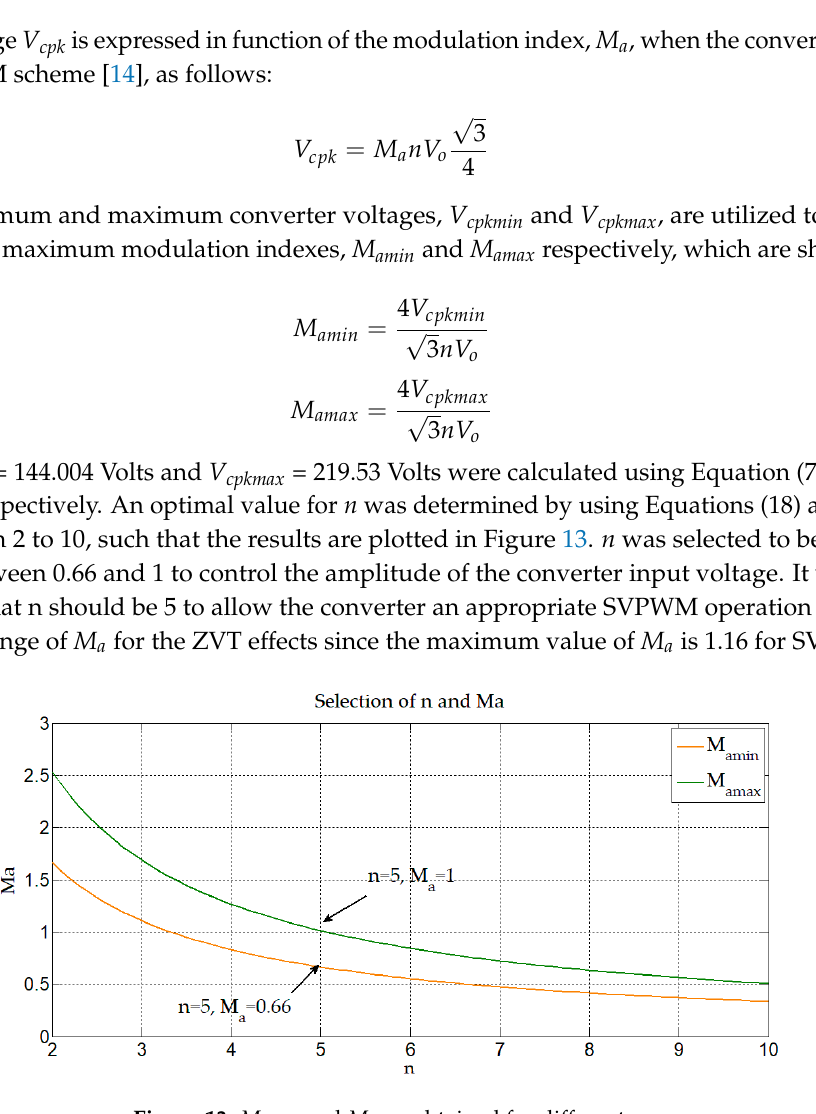
Table 4. Simulation Parameters.